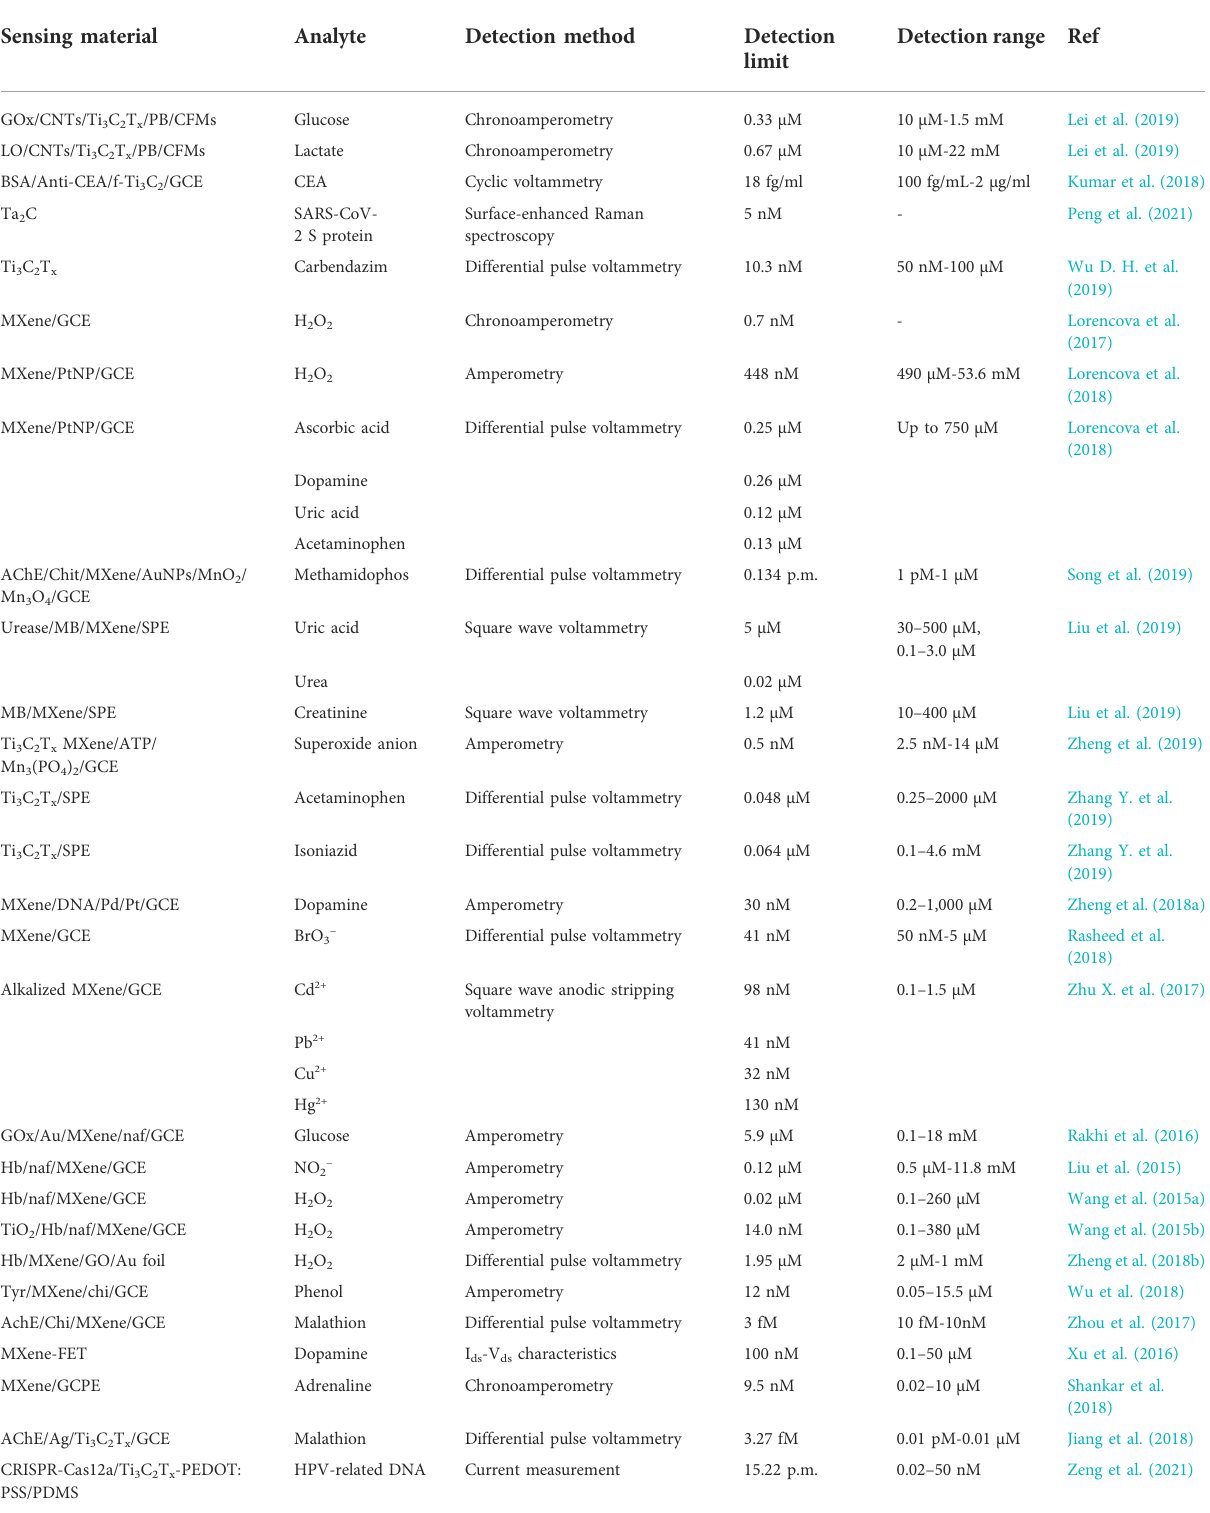
TABLE 4 Summary of MXene-based electrochemical